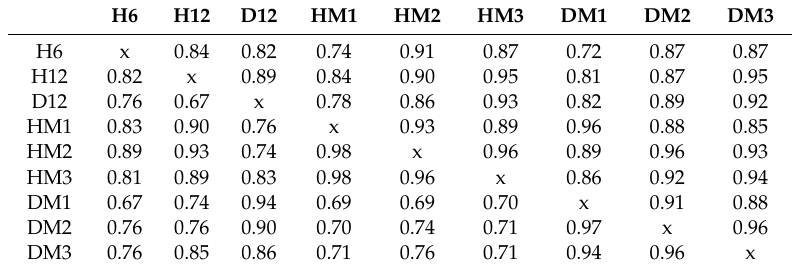
Table 3. Age–age genetic correlations (below the diagonal) and phenotypic correlations (above the diagonal) between measured and estimated traits.